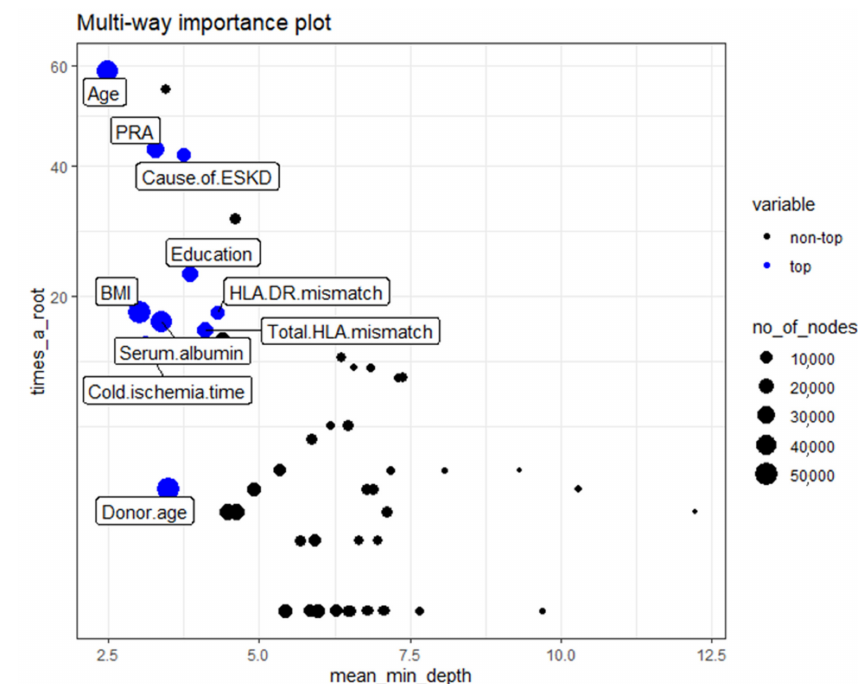
Figure 3. Classification of the top and not top variables based on the minimum average depth, number of nodes, and times to root. The 10 top variables are highlighted in blue. The size of points reflects the number of nodes split on the variable. Times_a_root: total number of trees in which the variable is used for splitting the root node. Mean_minimal_depth: mean minimal depth. Abbreviations: BMI—Body mass index; ESKD—Endstage kidney disease; HLA—Human Leukocyte antigen; PRA—Panel reactive